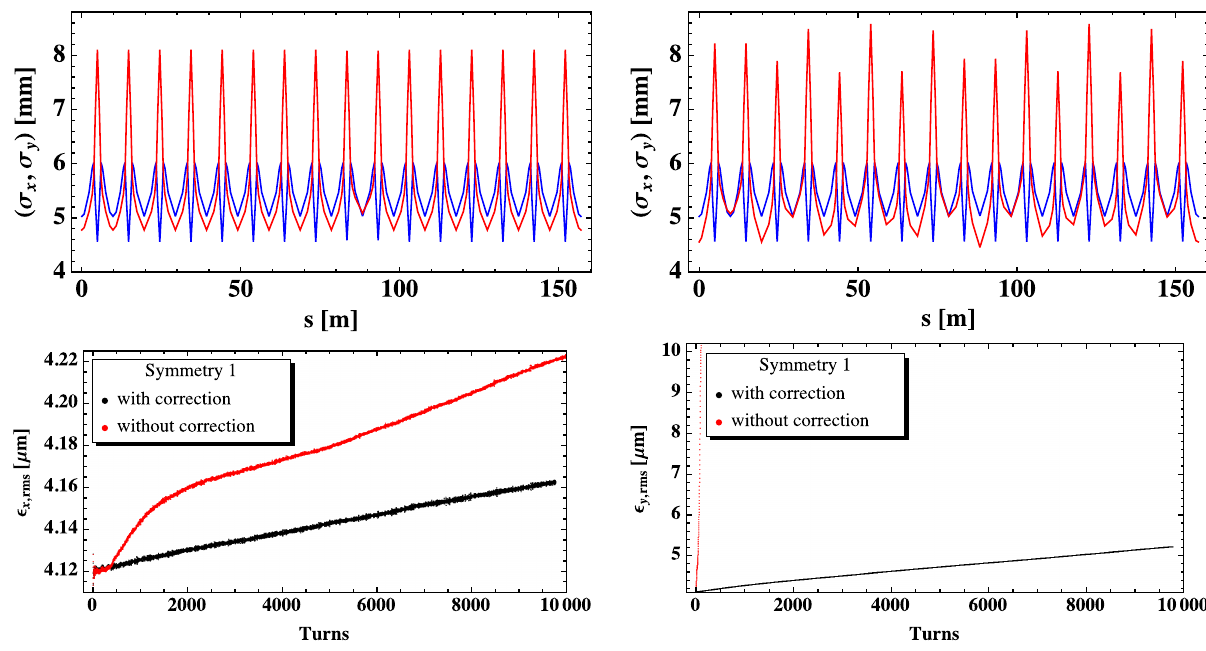
FIG. 16. One rms beam envelope (top) and time evolution of the emittance (bottom) of the regular 16-cell triplet lattice with onefold symmetry and a working point of Q x =Q y ¼ 4 . 28 = 3 . 55 . The beam envelope has been calculated using the design transverse normalized rms emittance of 2 . 5 μ m and the rms momentum spread corresponding to the design longitudinal emittance of 2.8 eVs. The one rms beam envelope with beta-beating correction is shown on the upper left and without beta-beating correction on the upper right. The horizontal (left) and vertical (right) time evolution of the emittance for the lattice with and without beta-beating correction is shown on the